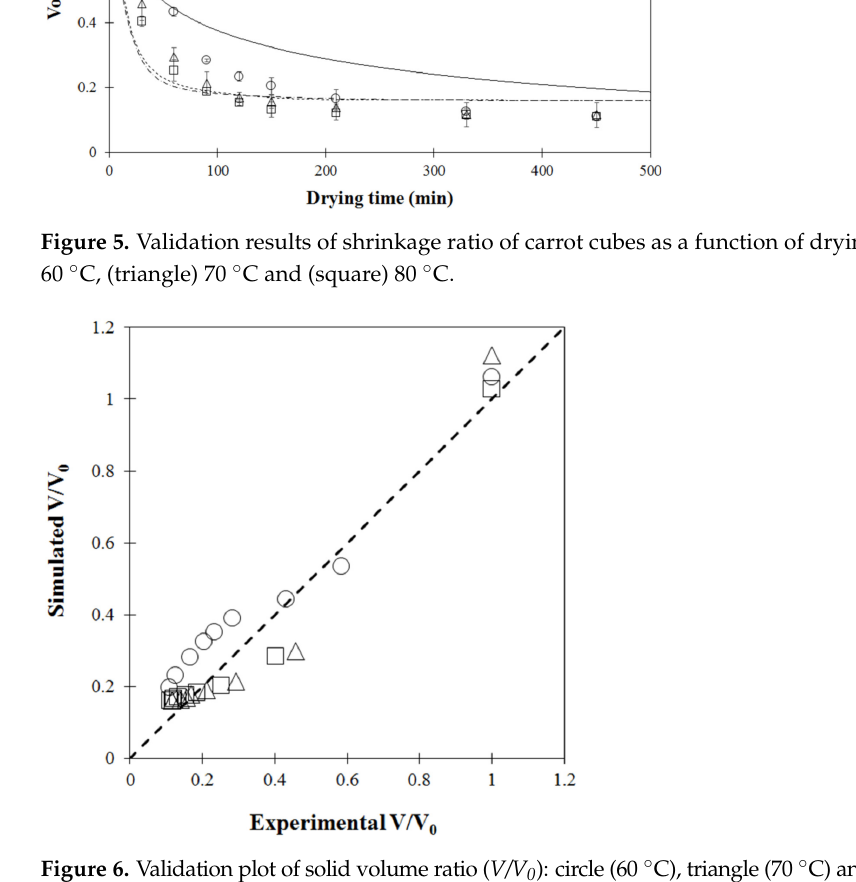
Figure 6. Validation plot of solid volume ratio ( V/V 0 ): circle (60 ◦ C), triangle (70 ◦ C) and square (80 ◦